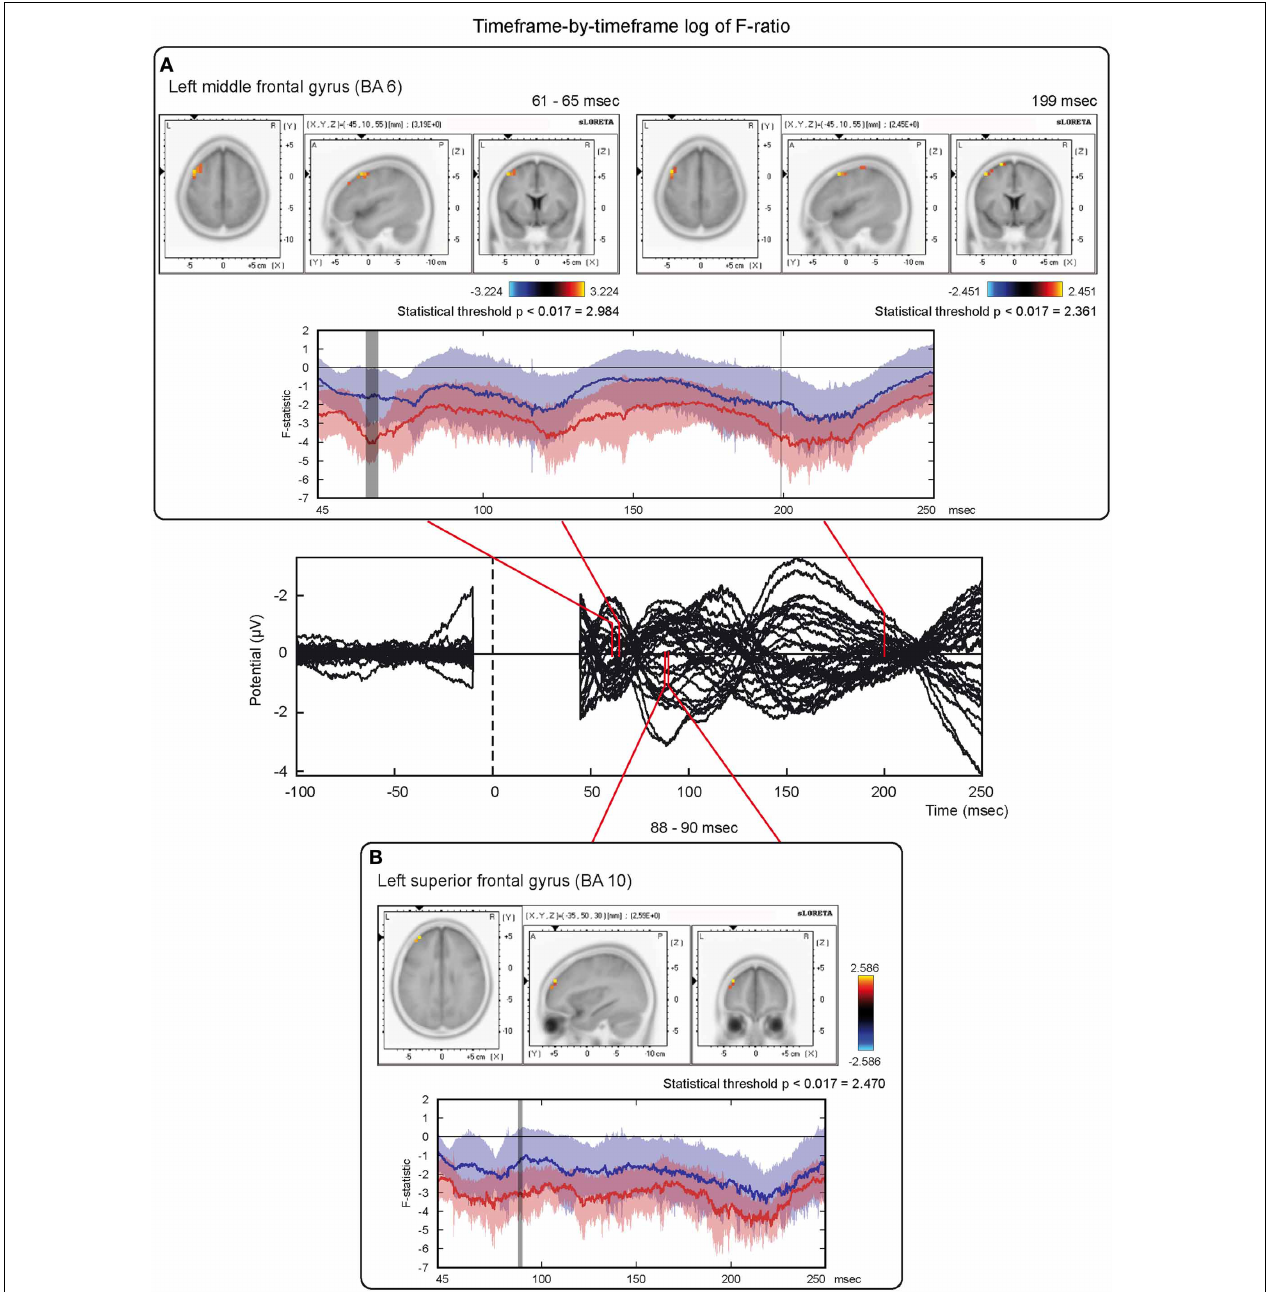
FIGURE 5 | Time-frame by time-frame sLORETA results (2). Principal sLORETA results obtained when considering a time-frame by time-frame analysis performed with log of F-ratio and comparing real TMS minus sham conditions. Images are plotted with respect to the time windows identified in a butterfly plot of the evoked potentials obtained from the real TMS condition. (A) Results obtained in the 61–65ms time window and results obtained 199ms after the delivery of TMS. Activations with the maximal peak in the left middle frontal gyrus (BA 6) are shown. (B) Results obtained in the 88–90ms time window. Activation with the maximal peak of activation in the left superior frontal gyrus (BA 10) is shown. The time course of the intensity of the signal in the source space is also shown.